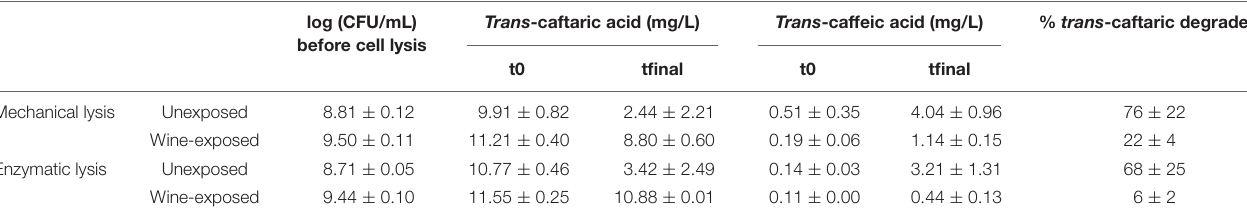
TABLE 4 | Cinnamoyl esterase activity of cell-free extracts of O. oeni strain CH16TM, grown in MRS medium mixed (wine-exposed) or not (unexposed) with 30% pasteurized wine, obtained after applying the mechanical and enzymatic lysis protocols. log (CFU/mL) Trans -caftaric acid (mg/L) Trans -caffeic acid (mg/L) % trans -caftaric degraded before cell lysis t0 tfinal t0